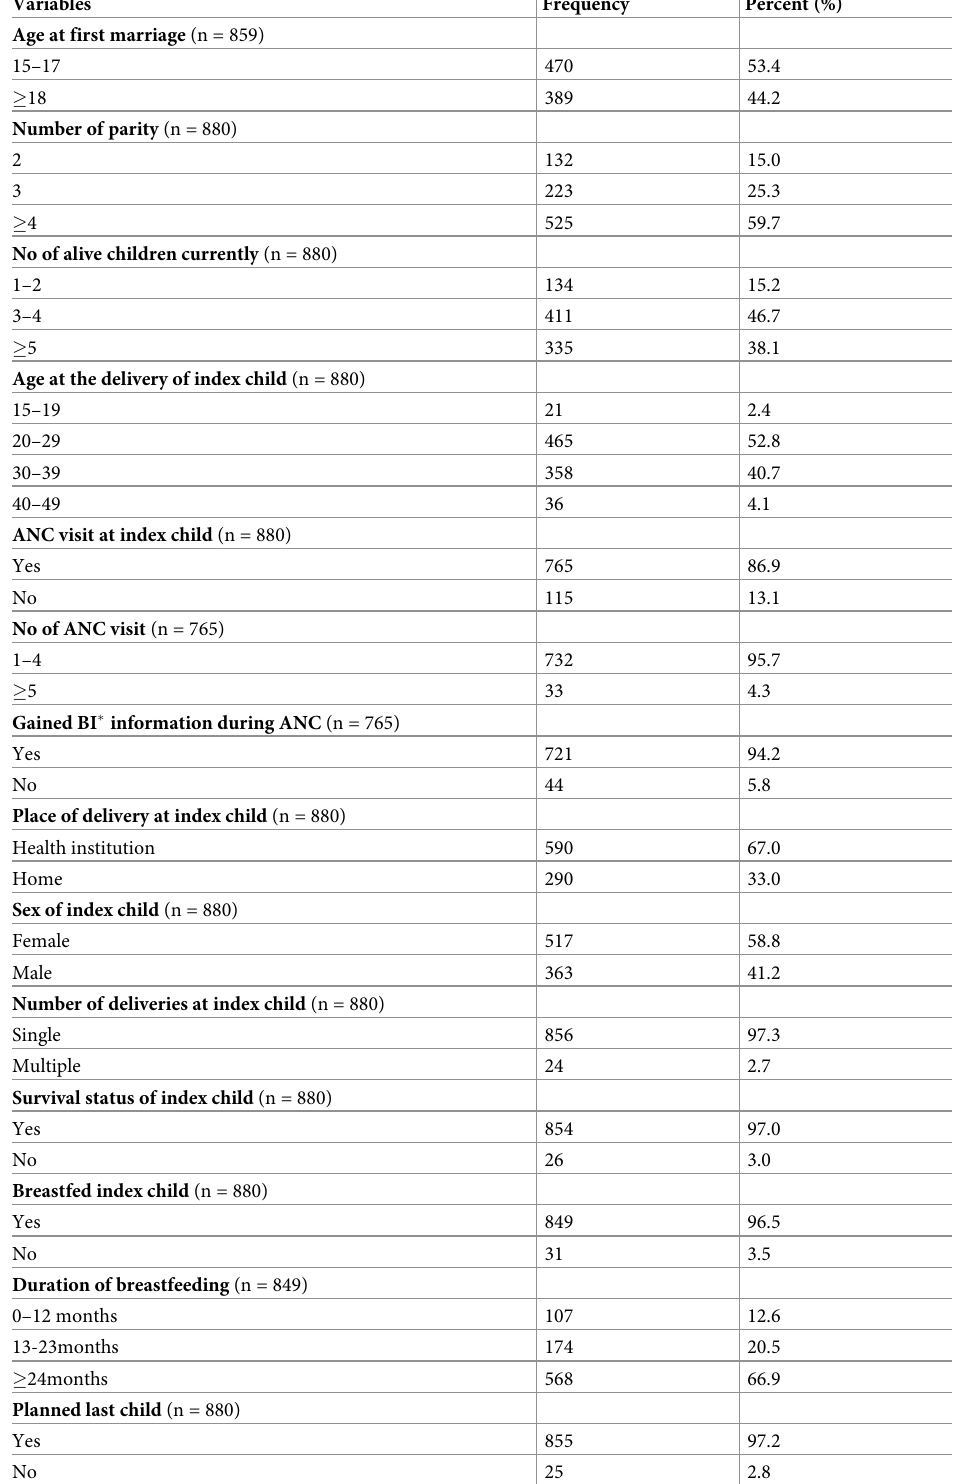
Table 2. Reproductive history of study participants in Dembecha districts, North West Ethiopia,